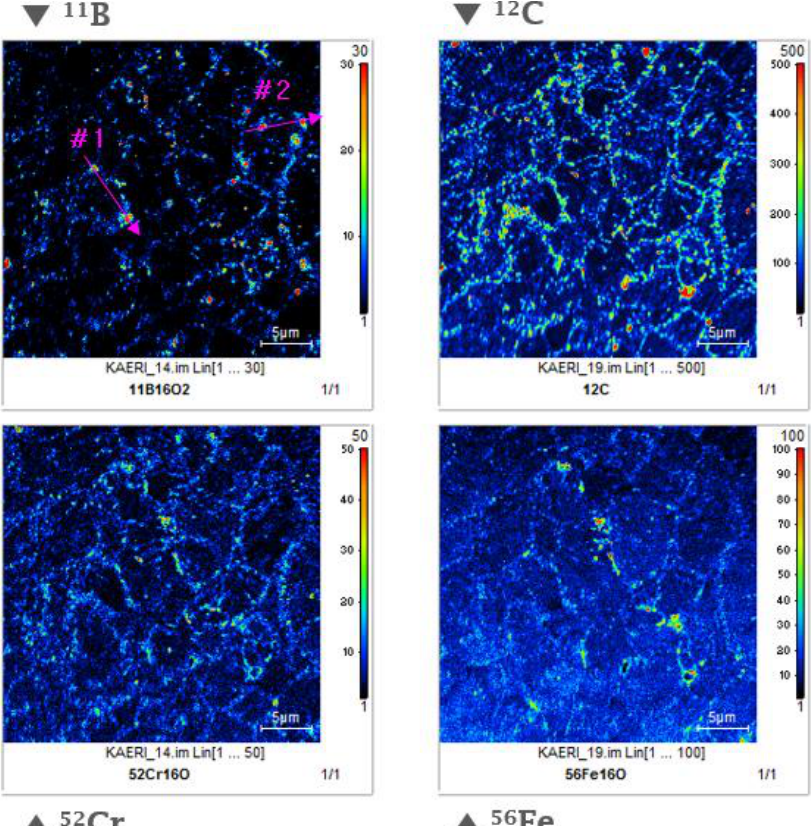
Figure 13. Nano-secondary ion mass spectrometry (Nano-SIMS) Images of B, C, Cr, and Fe of the alloy B specimens heat-treated under the 1050 °C, 6 min and 800 °C, 6 min conditions.